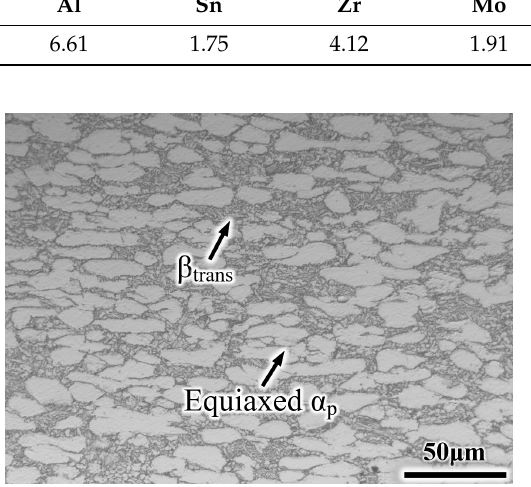
Table 1. Chemical components of the material (wt %).